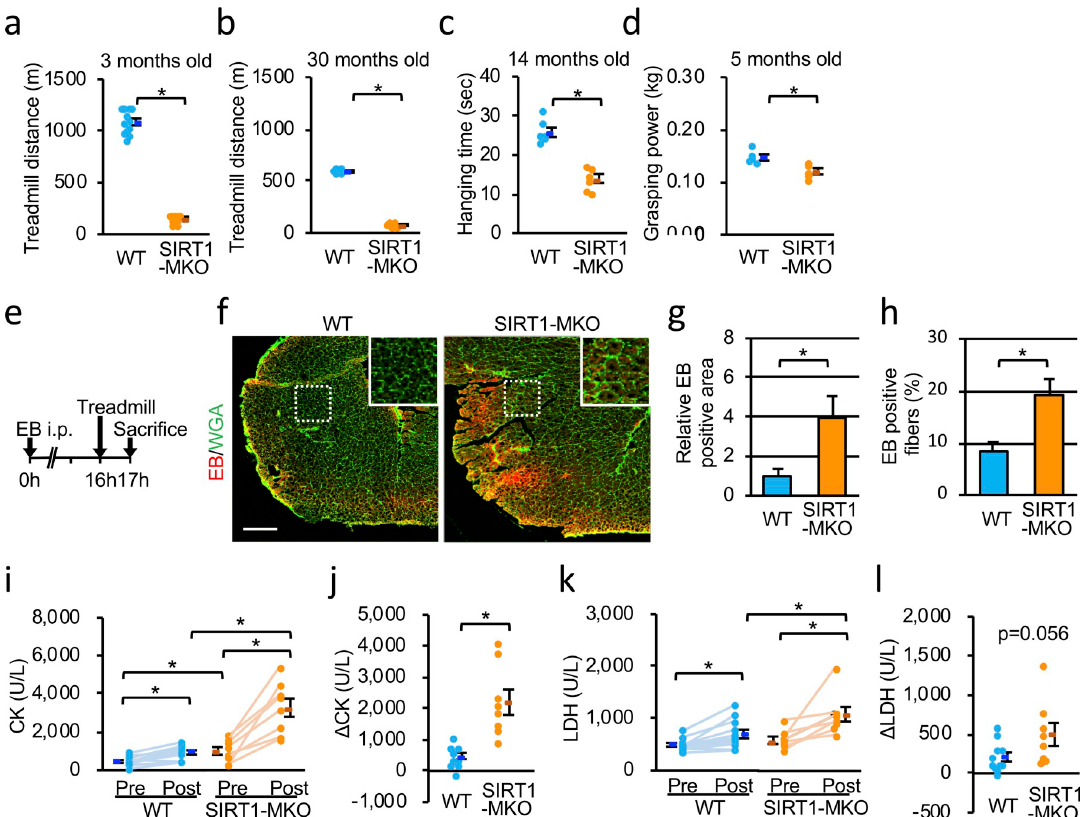
Fig 2. SIRT1-MKO mice have muscle fragility with reduced exercise endurance and strength. (a, b) Treadmill activity of WT and SIRT1-MKO mice at 3 months of age (a: n = 12) and 30 months of age (b: n = 6). (c) Hanging time after treadmill exercise of WT and SIRT1-MKO mice at 12 months of age (n = 6). (d) Grasping power of WT and SIRT1-MKO mice at 5 months of age (n = 5). (e) A schema of Evans blue dye (EB) uptake experiments. (f) Representative images of EB (red) uptake into quadriceps myofibers of WT (left) and SIRT1-MKO (right) mice 1 h after treadmills exercise. Scale bar is 500 μ m. (g) The EB-positive area of WT and SIRT1-MKO mice (n = 4). (h) The percentage of EB-positive fibers of WT and SIRT1-MKO mice (n = 4). (i) Serum creatine kinase activities (CK) of WT and SIRT1-MKO mice before (Pre) and after (Post) treadmill experiments. (k) Serum lactate dehydrogenase activity (LDH) of WT and SIRT1-MKO mice before (Pre) and after (Post) treadmill experiments. (j and l) The differences in CK (j: Δ CK) and LDH (l: Δ LDH) activities before and after treadmill experiments (n = 11 and 8 in WT and SIRT1-MKO mice, respectively). Data are represented as means ± SEM and significant differences in (a)-(d), (g), (h), (j) and (l) were determined by a two-tailed Student’s t -test. � p < 0.05. Two- way repeated measures ANOVA and Student-Newman-Keuls post hoc tests were performed to determine significant differences in (i) and (k).